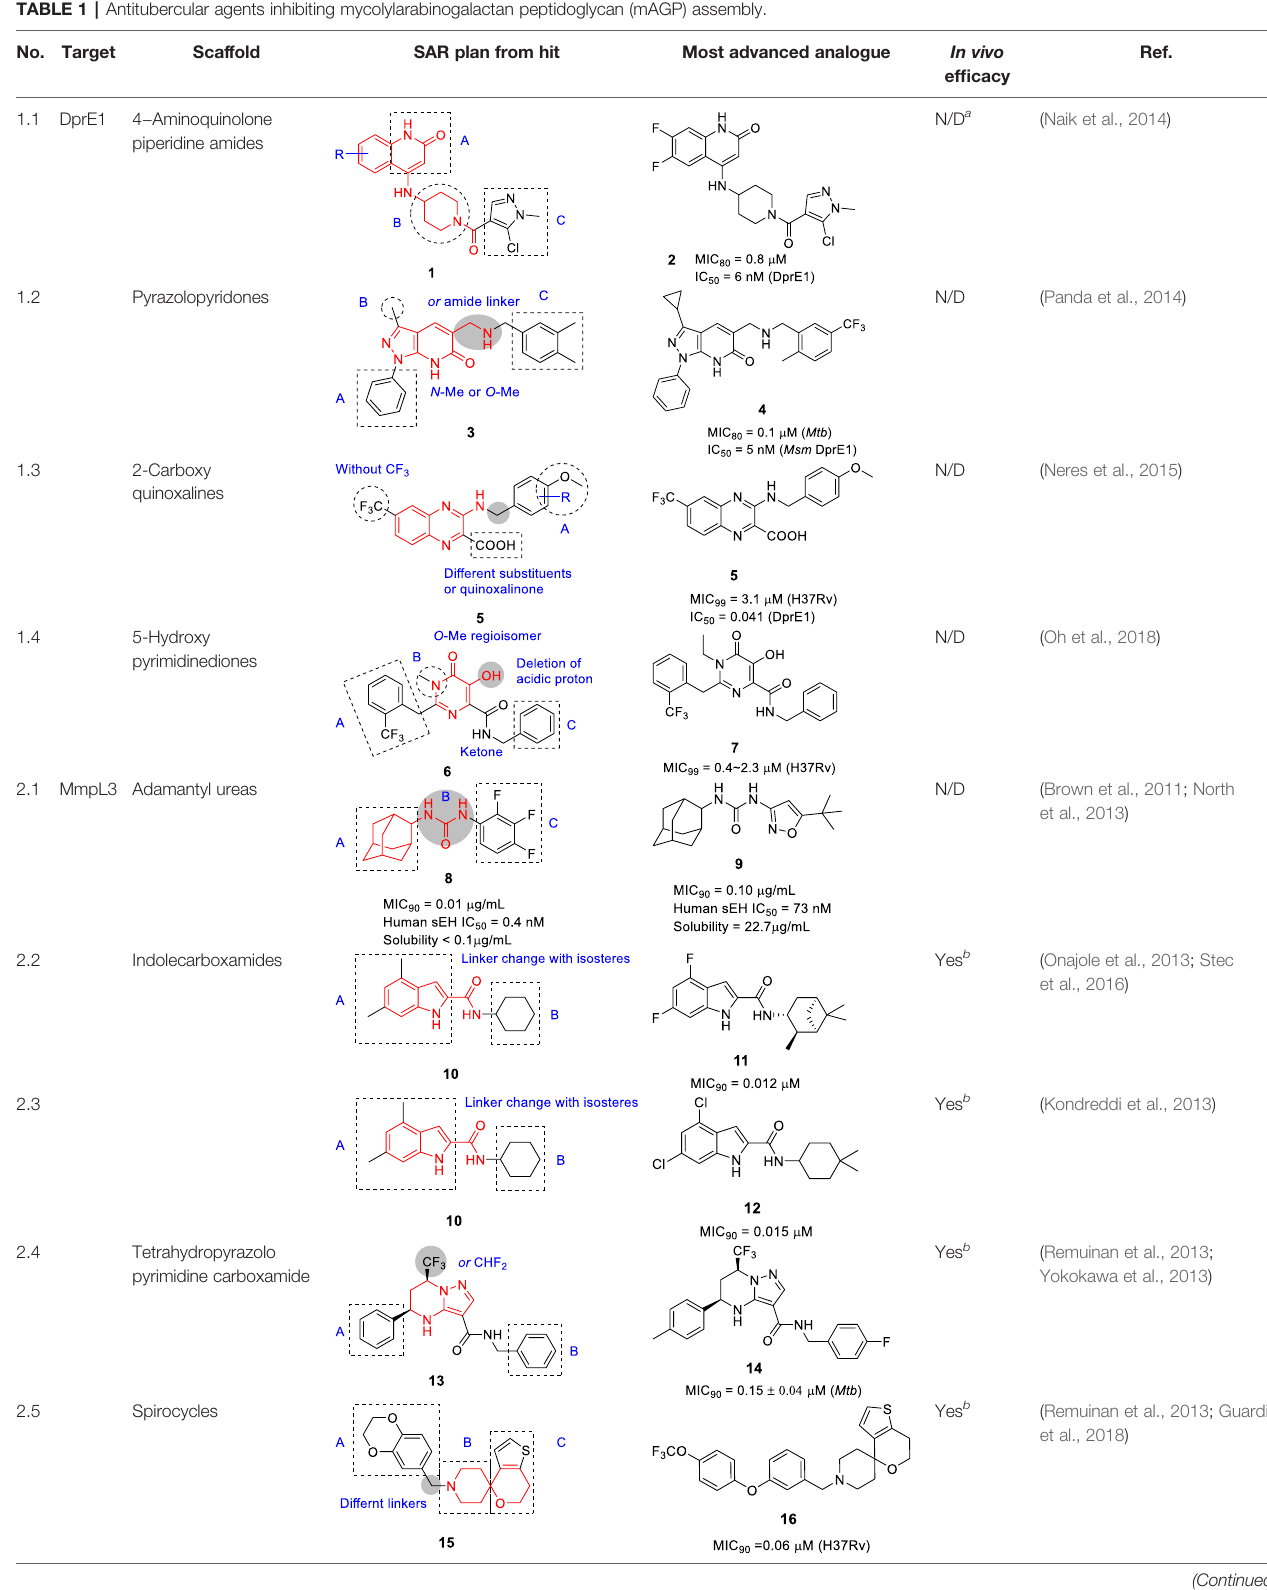
TABLE 1 | Antitubercular agents inhibiting mycolylarabinogalactan peptidoglycan (mAGP) assembly. No. Target Scaffold SAR plan from hit Most advanced analogue In vivo